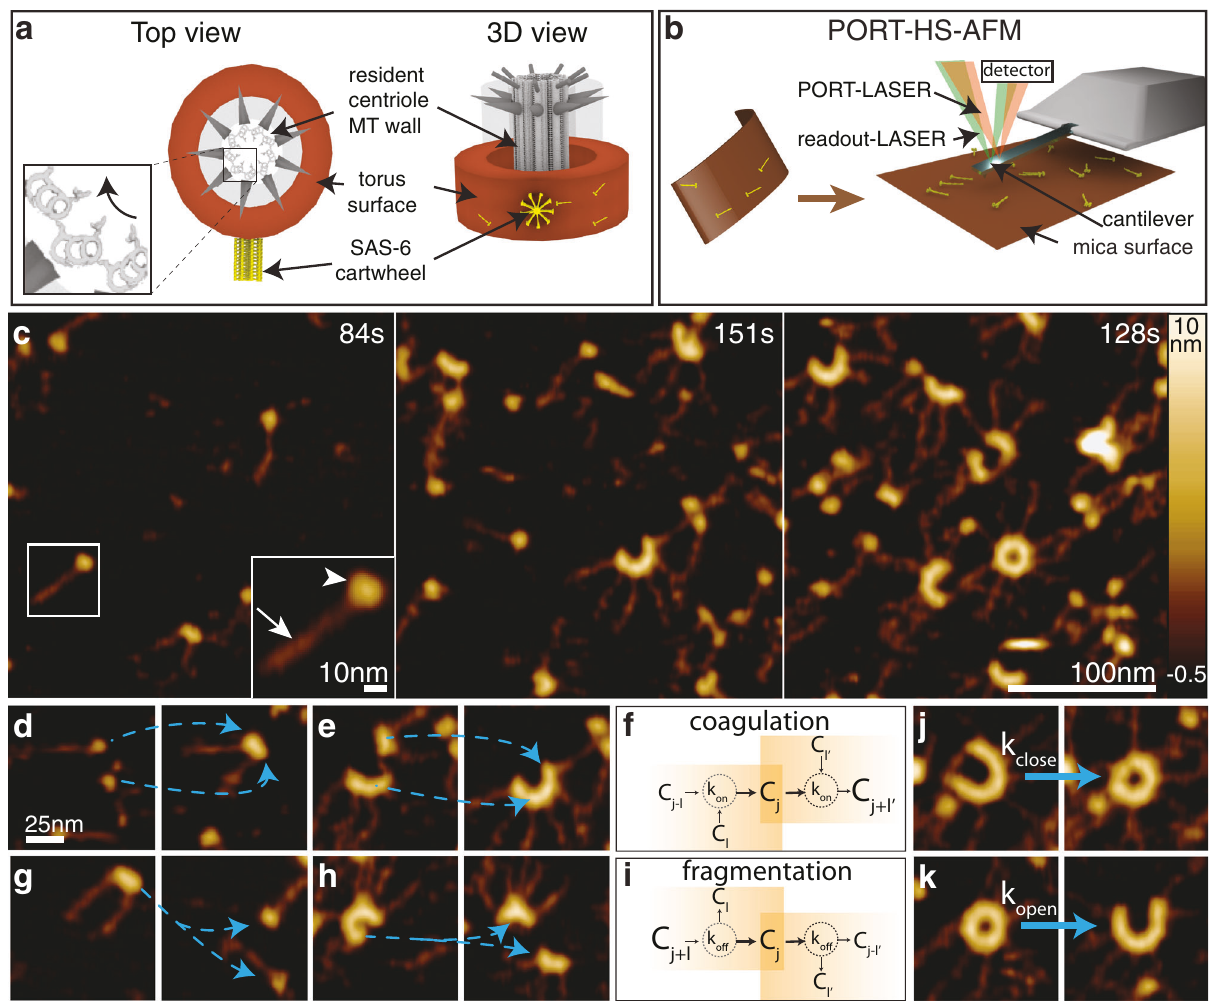
Fig. 1 PORT-HS-AFM of surface guided SAS-6 self-assembly exhibits characteristics of coagulation-fragmentation system. a Schematic top view (left, viewed from the distal end) and 3D front view (right) of centriole with chiral arrangement of microtubule (MT) wall (bottom left inset, see curved arrow) surrounded by toroidal surface (brown) and cartwheel formed by SAS-6 homodimers (yellow). Note that the cartwheel emerges orthogonal to the resident centriole, including in Chlamydomonas 67 . b Illustration of correspondence between torus surface and mica surface in PORT-HS-AFM setting. In PORT-HS- AFM, SAS-6 homodimers are adsorbed on the mica surface where their shape and position are probed by the cantilever, the motion of which is actuated by the PORT-LASER, with height monitored by the readout-LASER. c Frames from SAS-6 self-assembly reaction monitored with PORT-HS-AFM. Higher magni fi cation inset at 84s shows single homodimer with head domain (arrowhead) and spokes (arrow). Here and hereafter: time relative to start of recording. See also Supplementary Movie 1 (for c – e , g , h ). d , e Association of SAS-6 homodimers monitored by PORT-HS-AFM ( d : 1-mer + 1-mer = 2-mer, e : 4-mer + 2-mer = 6-mer). Here, as well as in g , h , j and k , pairs of frames are 2.52s apart and transitions are marked by blue dashed arrows. f Coagulation reactions can lead to either appearance or disappearance of an intermediate j-mer. Here and in i , see Eq. (1) in text and Supplementary Note 1 for details. g , h Dissociation of SAS-6 homodimers monitored by PORT-HS-AFM ( g : 2-mer = 1-mer + 1-mer, h : 7-mer = 4-mer + 3-mer). i Fragmentation reactions can lead to either appearance or disappearance of an intermediate j-mer. j , k SAS-6 ring closing ( j ) and opening ( k )